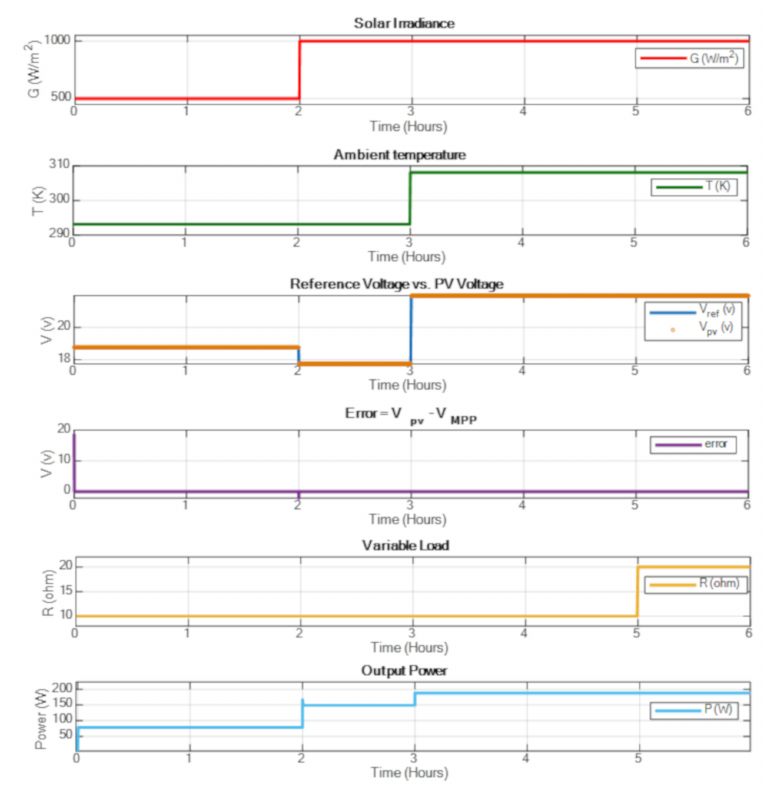
Figure 12. The proposed system performance with variations in variable temperatures, irradiances, and di ff erent loads.